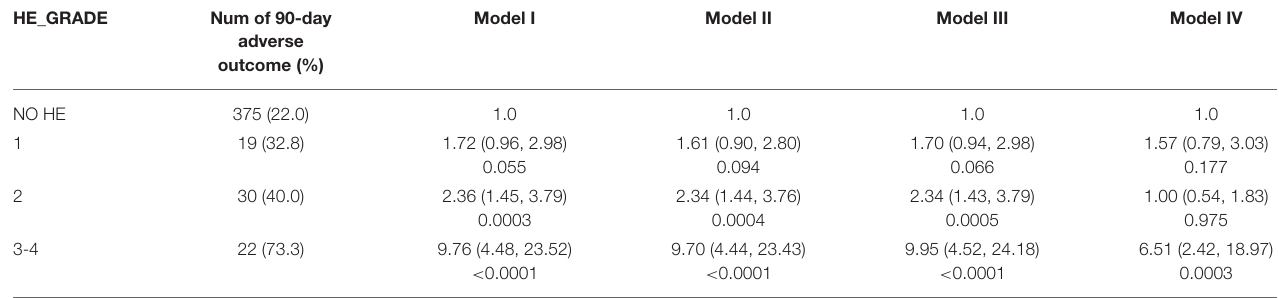
Model I, unadjusted. Model II, adjusted for age, sex, and etiology.